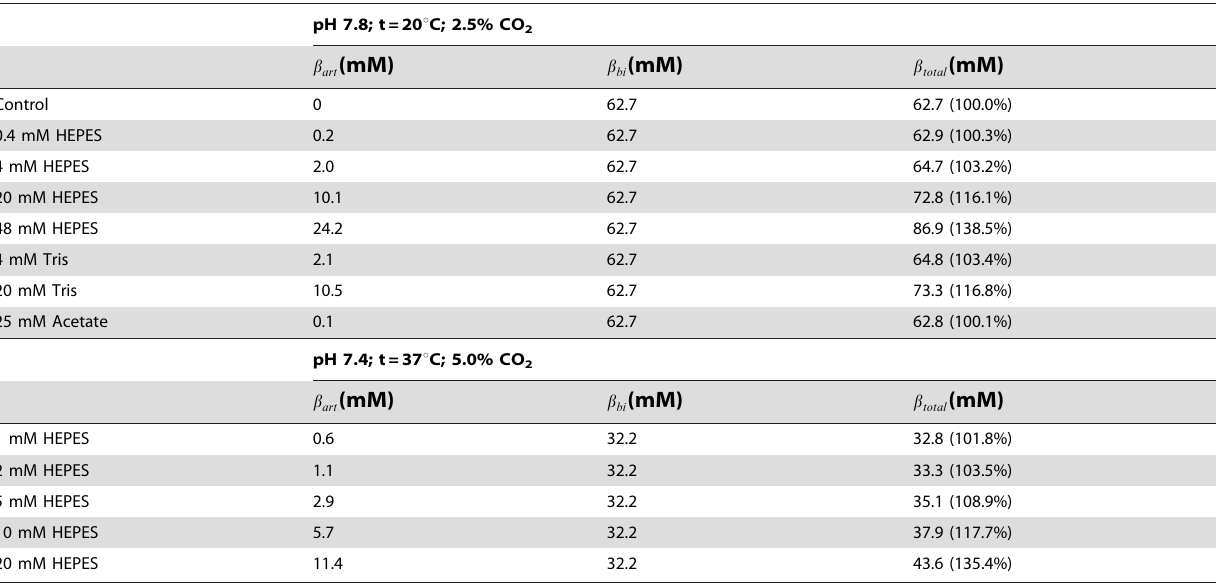
Table 3. Buffer capacities of Ringer’s